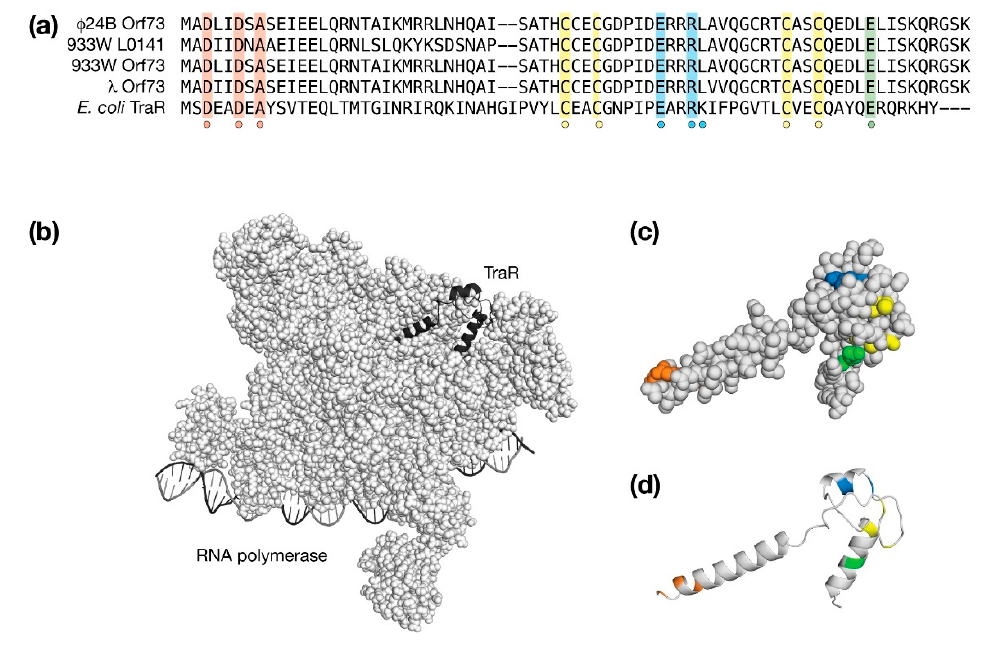
Figure 7. Molecular modeling the exo-xis protein, Orf73. ( a ) A sequence comparison of λ Orf73 and E. coli TraR. Similar and identical amino acids are shaded. A dot indicates conserved cysteines that coordinate one zinc ion. ( b ) Structure of the E. coli RNA polymerase (space filling representation), DNA (ribbon representation) and TraR (cartoon representation). ( c , d ) A ribbon and space filling representation of λ Orf73 following the same shading used in the sequence alignment.